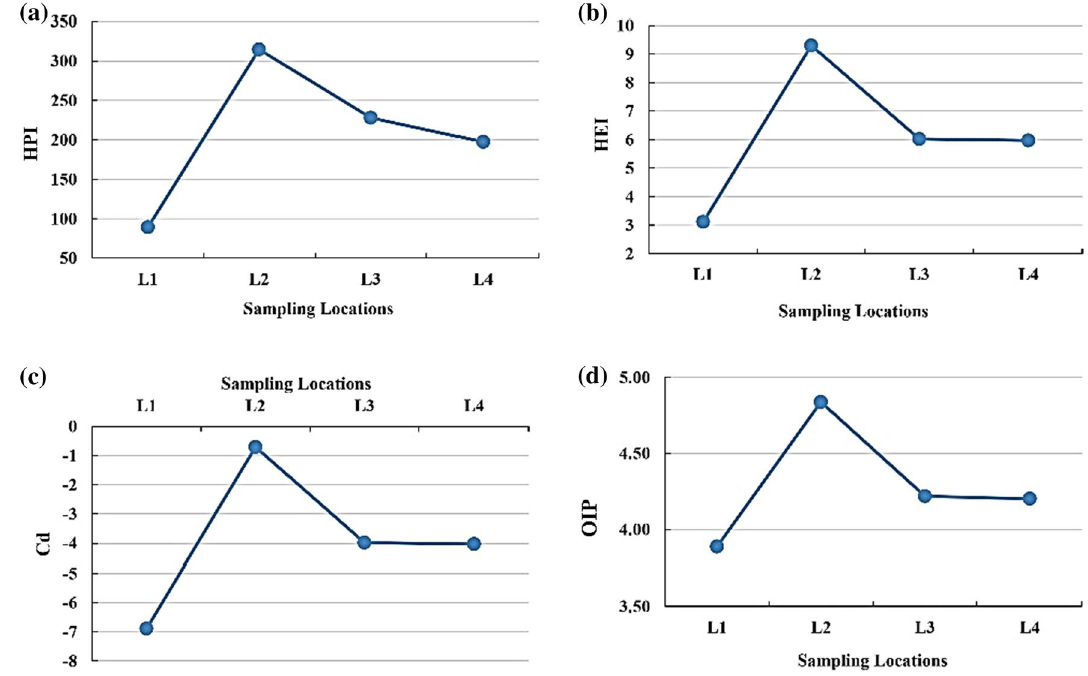
Fig. 3 Spatial distribution of pollution indices values within the study area